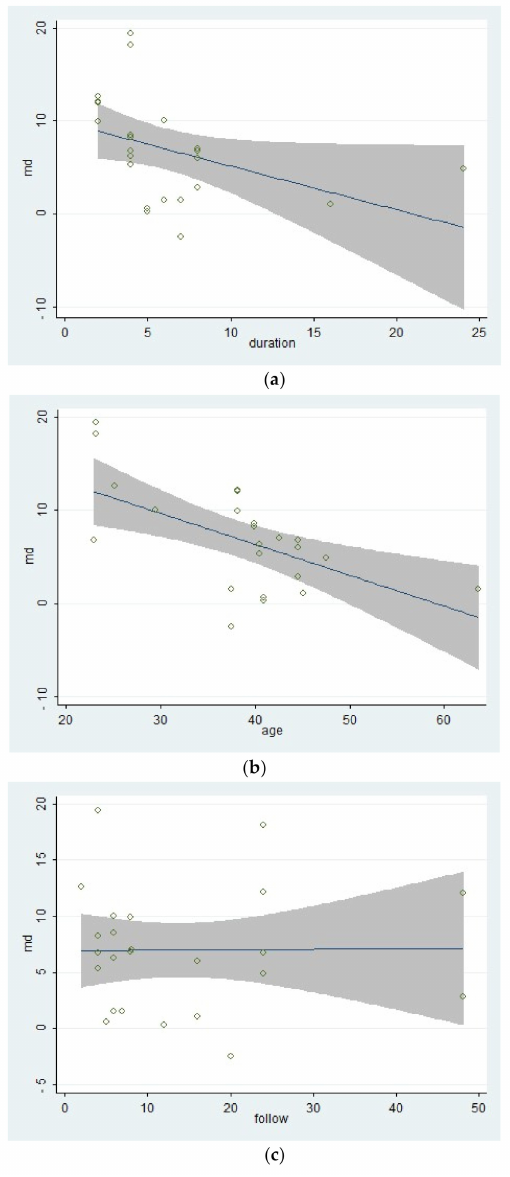
Figure 5. The bubble chats of the results of the three covariates in the meta-regression: ( a ) The duration of treatments; ( b ) Mean age of participants; ( c ) Follow-up times. Table 6. Meta-regression result: The follow-up times and the SMD of e ff